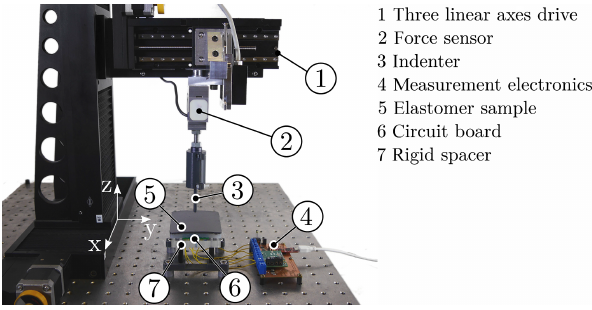
Figure 3. Test setup for sampling the sensor.